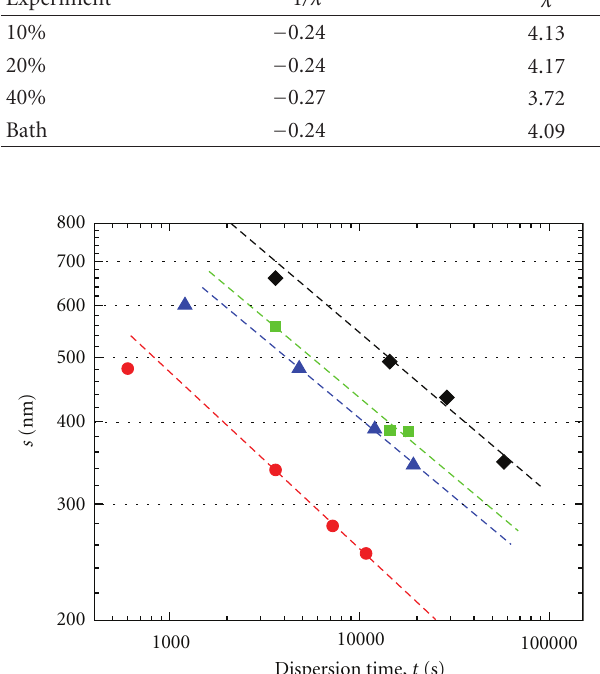
Figure 16: Mean agglomerate size data from fitted log-normal functions as a function of sonication time, t , at di ff erent tip ampli- tudes: 10% ( (cid:2) ), 20% ( (cid:4) ), 40% ( • ), and bath sonicator ( (cid:3) ). For each tip amplitude, the three longest times were used to fit (4).